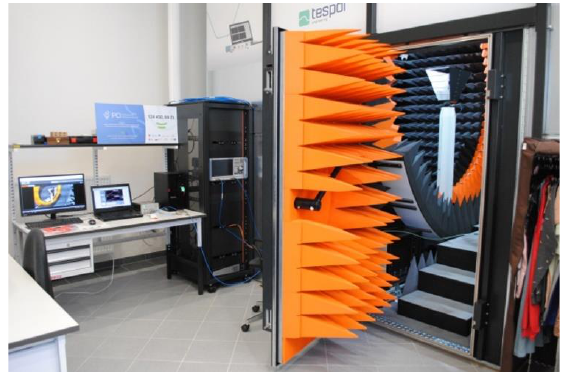
Figure 19. Laboratory experimental stand.